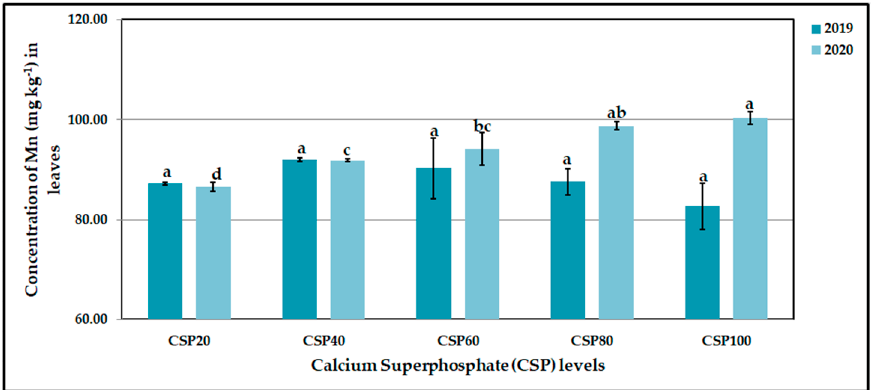
Figure 2. Influence of calcium superphosphate (CSP) levels on leaf manganese (Mn, mg kg − 1 ) contents of CaCO 3 ‐ stressed sweet potato plants in 2019 and 2020 seasons. Bars with a different letter indicate significant difference between treatments at p ≤ 0.05. CSP 20 , CSP 40 , CSP 60 , CSP 80 , and CSP 100 represent CSP added as a soil application at 69, 138, 207, 276, and 345 kg ha − 1 , respectively.